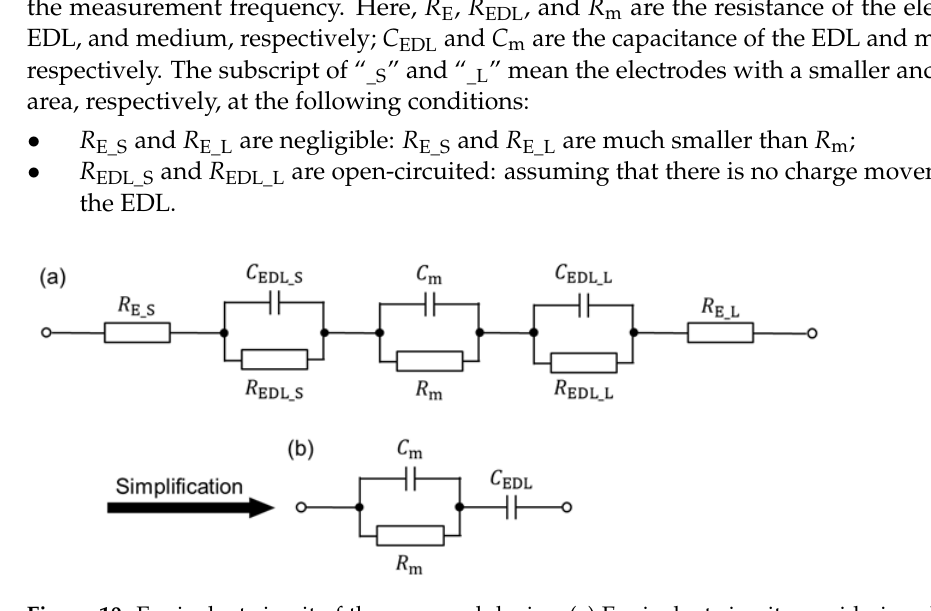
Figure 11. Measurement results of the proposed device. ( a ) Complex impedance locus with different σ m . The diameter of the semi-circle is proportional to the σ m (cid:2879)(cid:2869) . ( b ) The frequency, which is the contact point between the semi-circle by the medium and locus by the EDL against σ m .